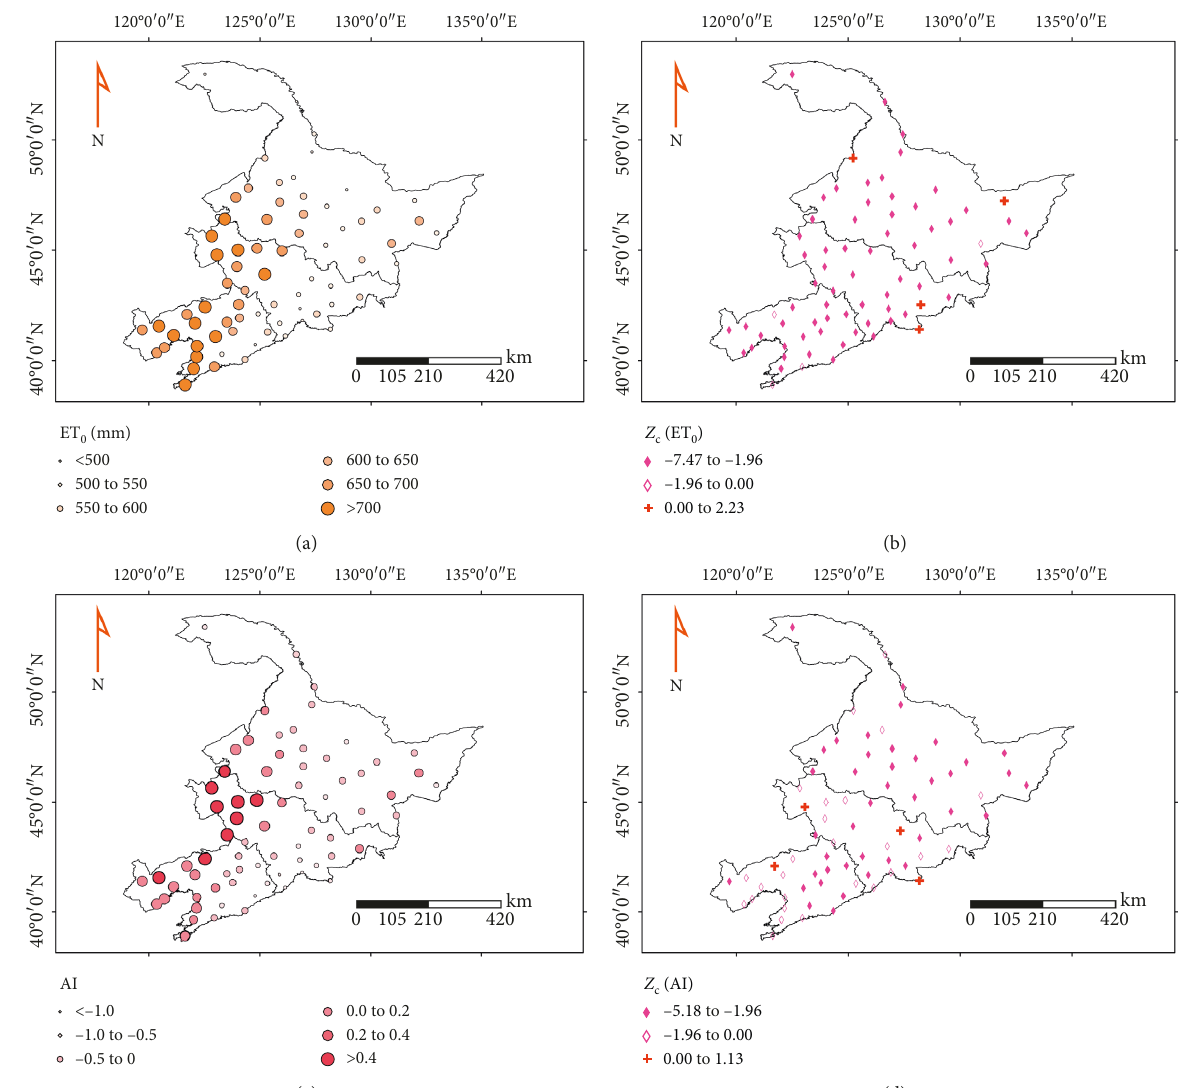
Figure 5: Spatial distributions of the M-K test and mean value of ET